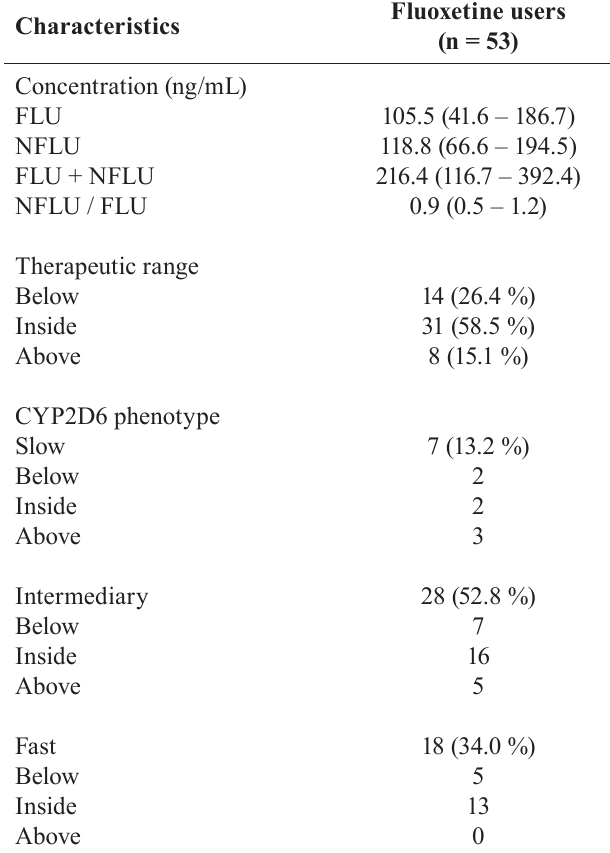
TABLE II - Classification of FLU users according to therapeutic range and CYP2D6 phenotype